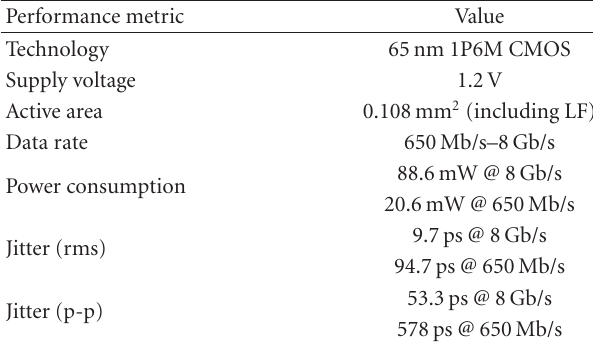
Table 1: Performance